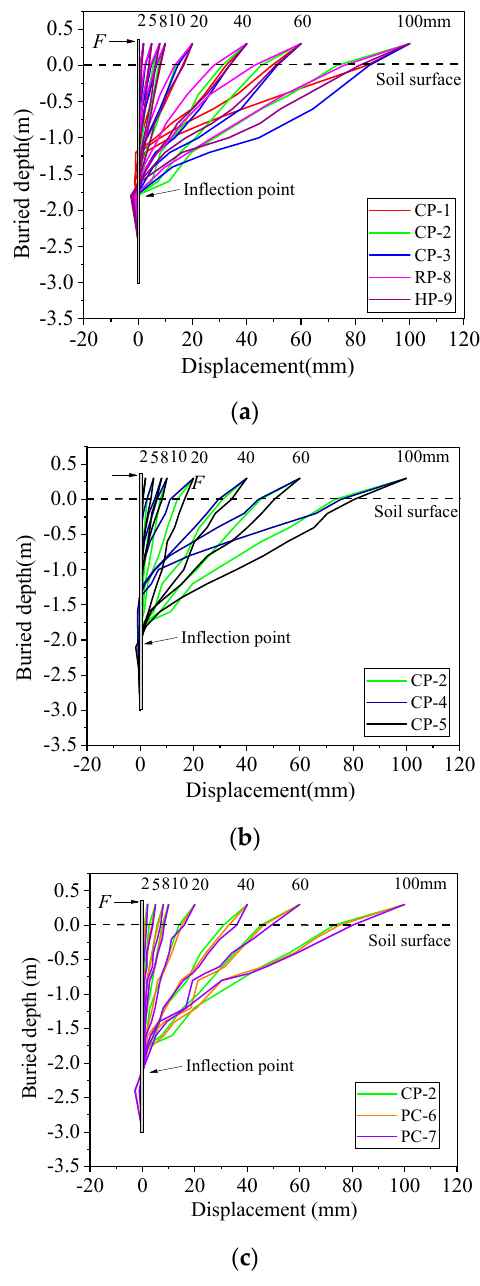
Figure 9. Deformed shapes of all specimens. ( a ) The effect of different reinforcement ratio. ( b ) The effect of different buried pile depth. ( c ) The effect of different prestressing level.